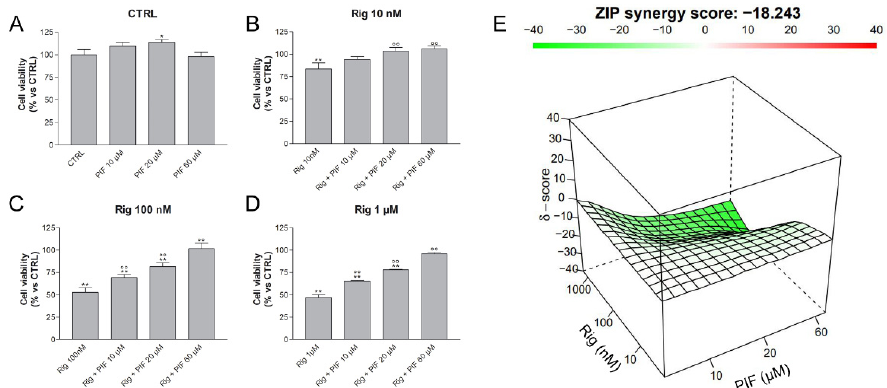
Figure 7. Cell viability of EGI-1 cells treated with different combinations of Rig and PIF. EGI-1 cells were treated for 24 h with different concentrations of PIF (0, 10, 20, 60 µ M), alone ( A ) or in combination with Rig 10 nM ( B ), Rig 100 nM ( C ) and Rig 1 µ M ( D ). Graphs are represented as the mean percentage ± SD compared to untreated control (CTRL), arbitrarily set to 100%, from at least three independent experiments. The antagonism of Rig and PIF combinations is calculated by the Synergy Finder web application and is represented in graph E: a green color indicates an antagonistic effect, a white color an additive effect, and a red color a synergistic effect. * p < 0.05 and ** p < 0.01 vs. CTRL; °° p < 0.01 vs. respective Rig.